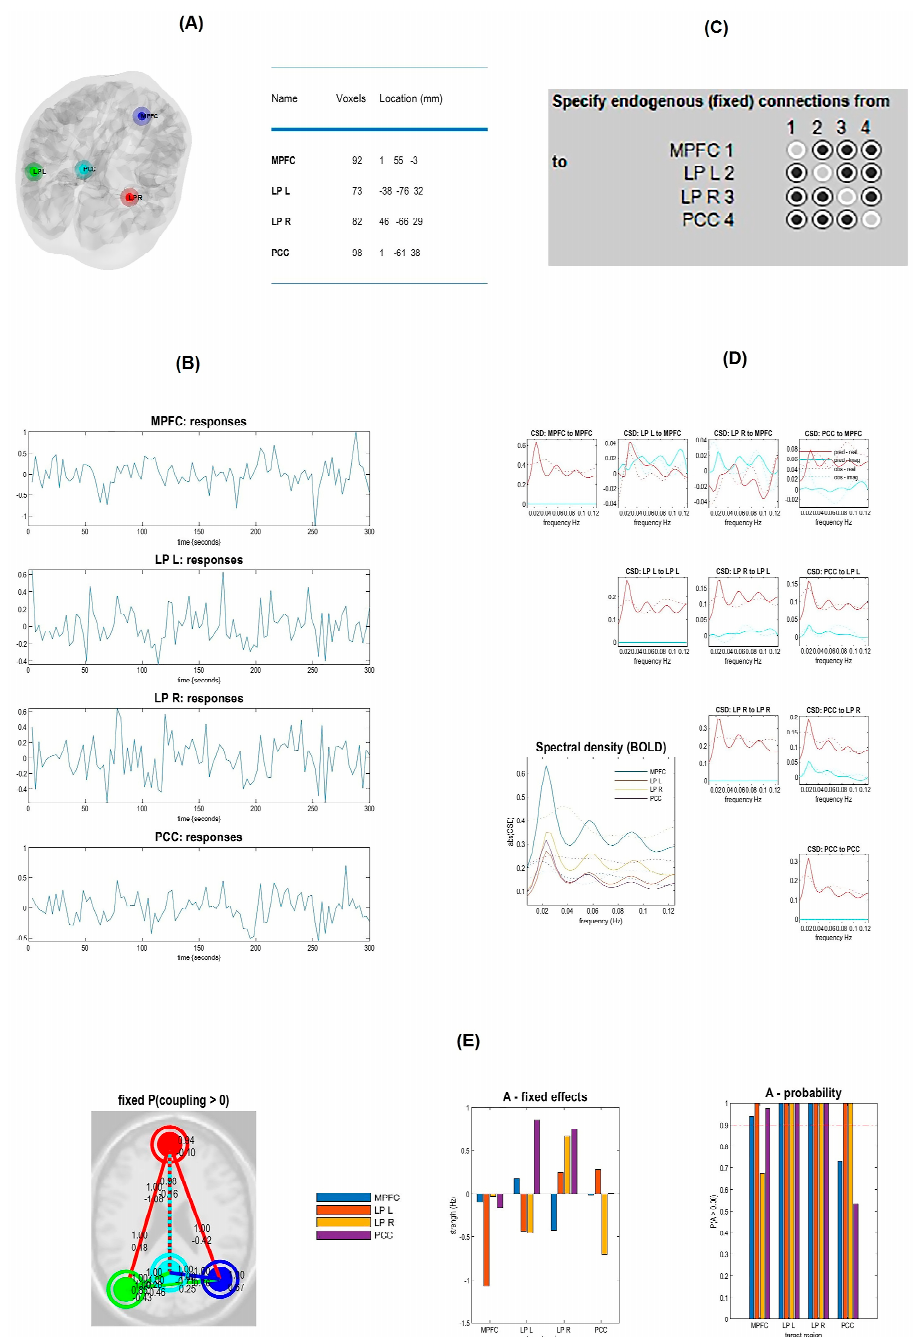
Figure 2. Spectral dynamic causal modeling analysis in the default mode network (DMN). ( A ) The coordinates’ nodes (MPFC: medial prefrontal cortex, LP(L): left lateral parietal, LP(R) right lateral parietal, PCC: posterior cingulate cortex) within the DMN. ( B ) Extracting Time series of DMN ‘s nodes. ( C ) Choosing model parameters (DCM with a fully connected model with no exogenous inputs and non-stochastic effect). ( D ) The plot of predicted (solid lines) and observed (dotted lines) cross-spectral densities after convergence show both self and cross spectra for four nodes. The lower panel describes self-cross spectra for four nodes. ( E ) The result of effective (fixed) connectivity between DMN ‘s nodes. The first and second panels show the estimated fixed A matrix, and the third panel shows the posterior probabilities of these endogenous connectivity parameters. The dashed line with red color indicates the 95% threshold.